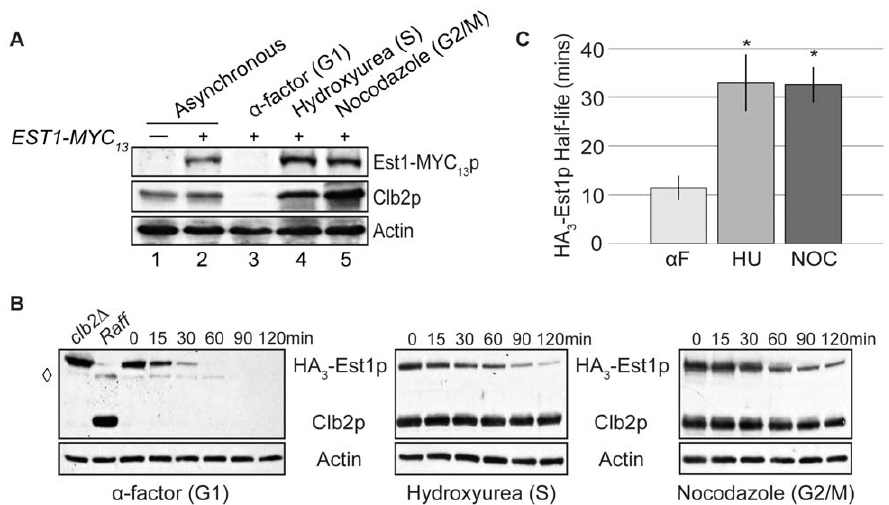
Figure 1. Est1p is unstable in G1 phase, but stable in early S and G2/M phases. (A) Endogenously expressed Est1p-MYC 13 p levels during cell cycle arrests. Strains YKF800 (untagged; lane 1) and YKF801 ( EST1-MYC 13 ; lanes 2–5) were grown asynchronously at 30 u C to mid-log phase and then left untreated (asynchronous) or arrested by addition of a -factor, hydroxyurea, or nocodazole, as indicated. When 95% of the population was arrested, as monitored by the bud-index, cells were harvested. Whole-cell extract was prepared and western blotted using anti-MYC, anti-Clb2p, and anti-Actin antibodies, as indicated. (B) Half-life of HA 3 -Est1p during cell cycle arrests. Strain YKF802 containing plasmid pVL242RtoA ( P GAL1 -HA 3 -EST1 ) was grown asynchronously at 30 u C to mid-log phase and arrested with a -factor, hydroxyurea, or nocodazole, as indicated. When 95% of the population was arrested, as monitored by the bud-index, expression of HA 3 -EST1 was induced with addition of galactose and then subsequently repressed (after 1 hour) with glucose and cycloheximide (time 0). Samples from cells harvested at the indicated times were western blotted with anti- HA, anti-Clb2p and anti-Actin antibodies, as indicated. An induced asynchronous sample of strain YKF806 + pVL242RtoA ( clb2 D ; left panel), served as a negative control for Clb2p and positive control for HA 3 -Est1p detection. An uninduced asynchronous sample of strain YKF802 + pVL242RtoA (Raff; left panel) served as a positive control for Clb2p detection and negative control for HA 3 -Est1p specificity. A non-specific background band is indicated by . (C) Quantification of data shown in (B), as described in Materials and Methods. The calculated half-lives were averaged from independent biological replicates: a F ( a -factor), n=7; HU (hydroxyurea), n=4; NOC (nocodazole), n=4. Error bars are standard deviation from the mean. Both HU and NOC are statistically different from a F by two-tailed t-test (p-values 1.1 6 10 2 5 and 1.1 6 10 2 6 , respectively) as denoted by